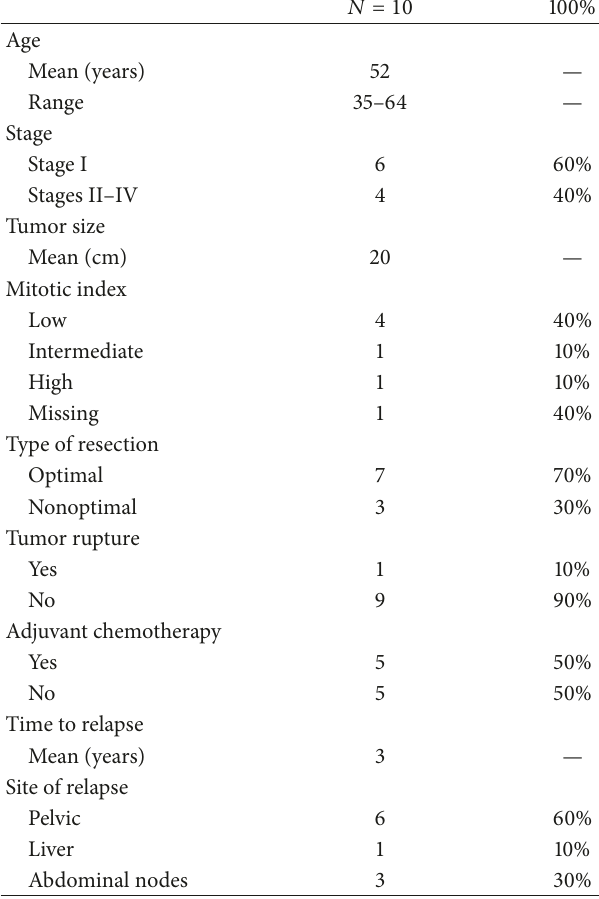
Table 1: Characteristics of patients with recurrent